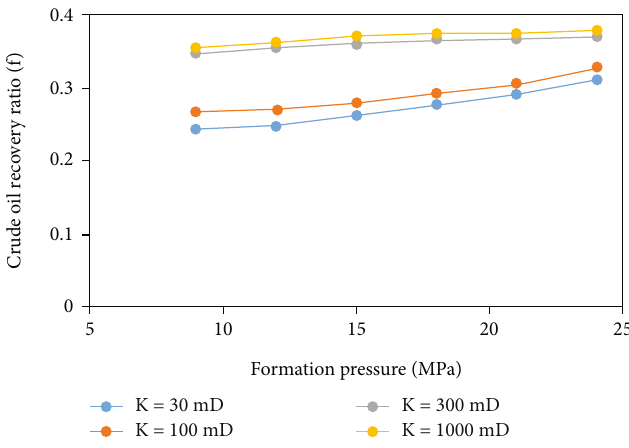
Figure 9: Determination of formation pressure maintenance levels of di ff erent reservoir properties.